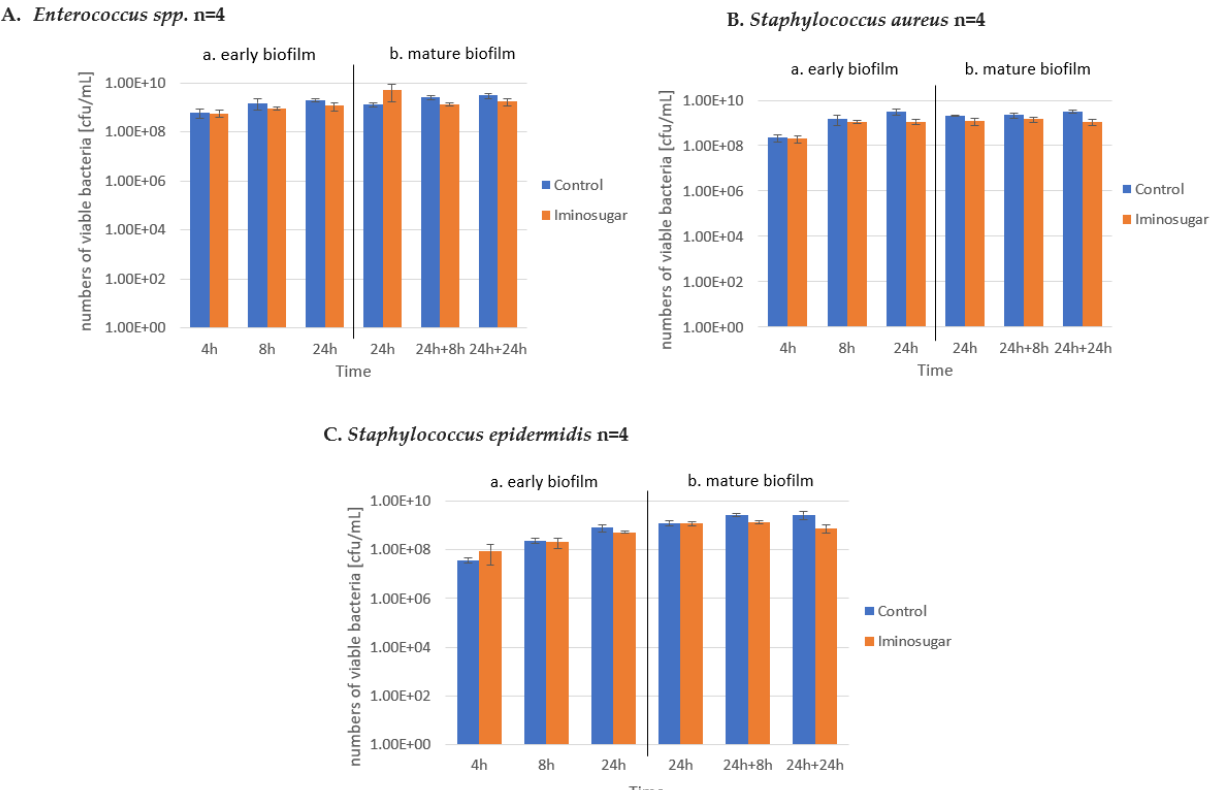
Figure 7. Effect of the tested iminosugar PDIA on numbers of viable population (n refers to the number of strains) of selected Gram-positive cocci for ( A ). Enterococcus spp. and ( B ) Staphylococcus aureus , and ( C ) Staphylococcus epidermidis in early ( a ) and mature ( b ) biofilm phase formation. Results depict logs of CFU/mL and measured at different time intervals. CFU, colony-forming units .